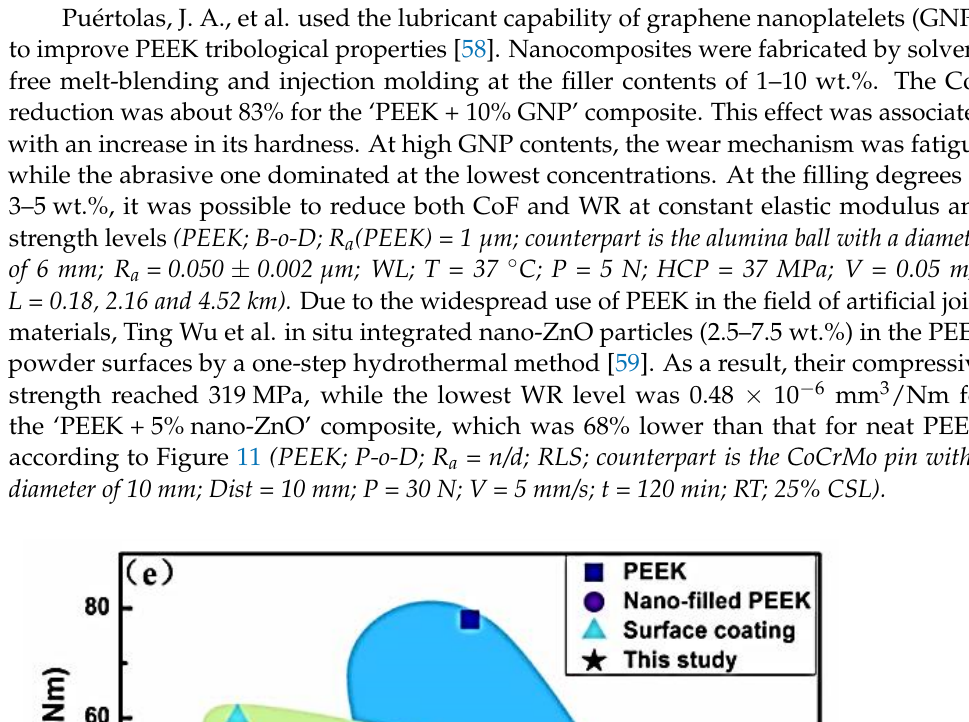
Figure 10. ( a ) Results of XRD analysis of the worn ‘PAI + PTFE’ coating surface and ( b ) a scheme of the tribochemical reactions. Figure is reproduced with permission from reference [57].